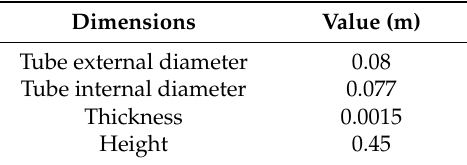
Figure 7. Fluidization column used in this study (units: m). Table 8. Dimensions of the fluidization chamber.